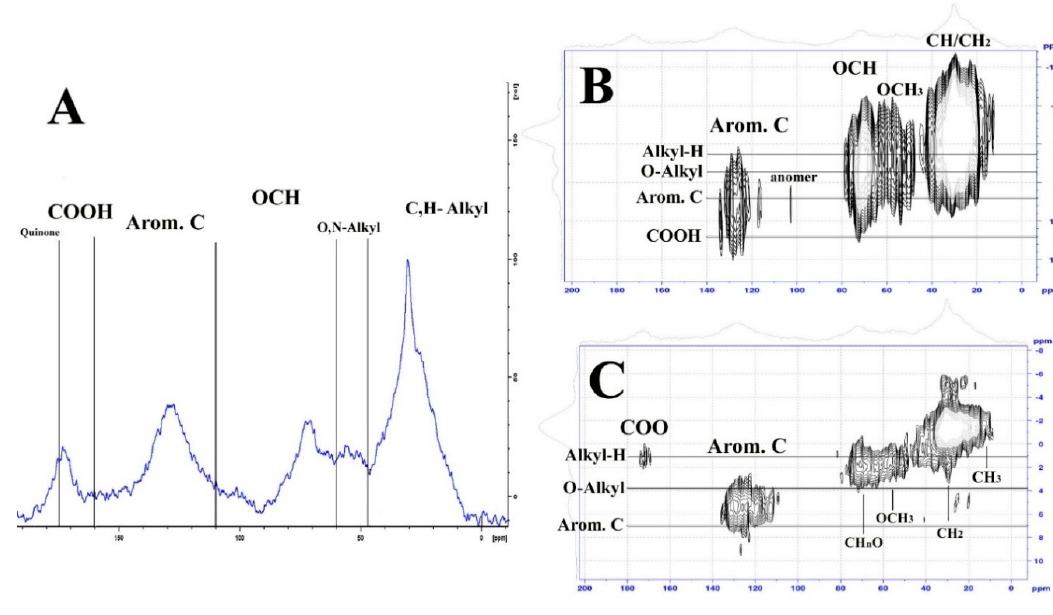
Figure 3. 1 H- 13 C (HETCOR) and 13 C (CP / MAS) NMR spectra of HAs isolated from cryoconite of Grønfjorden area, Spitsbergen ( A ) 13 C (CP / MAS) NMR; ( B ) 1 H- 13 C (HETCOR) NMR with contact time 0.1 ms; and ( C ) 1 H- 13 C (HETCOR) NMR with contact time 0.75 ms.